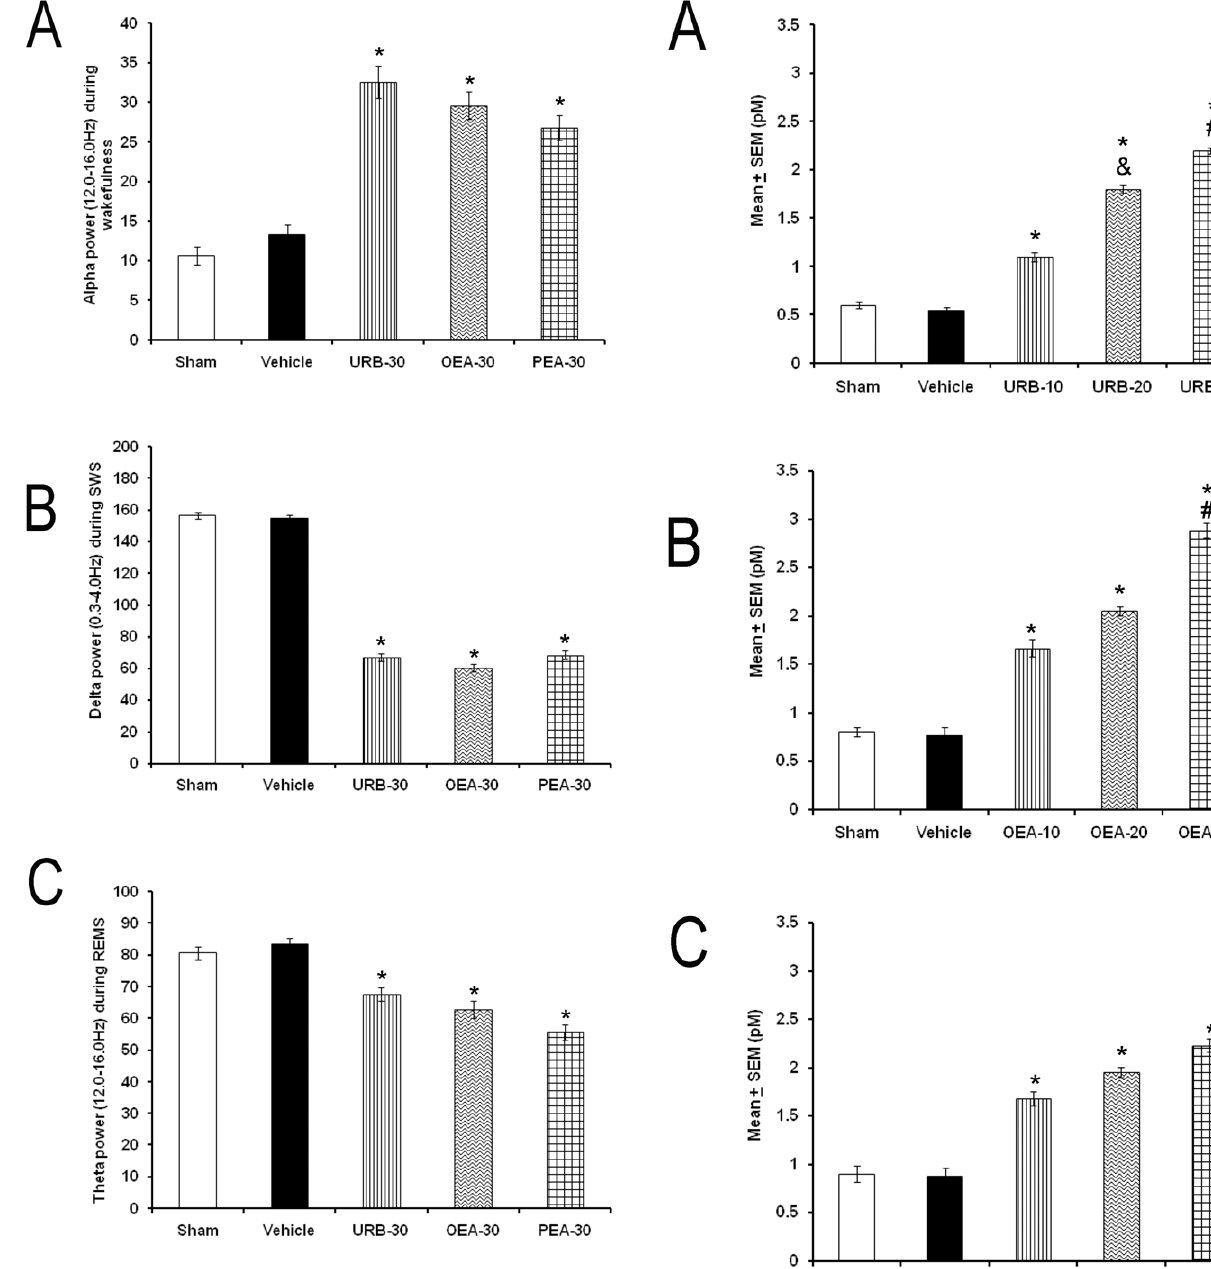
Figure 5. EEG alpha (for W; a =8–12 Hz. Panel A), delta (for SWS; d =0.5–4.0 Hz. Panel B) and theta (for REMS; h =6.0– 12.0 Hz. Panel C) power spectra (units, m V 2 ) in rats after the following treatments into dorsal raphe nuclei: Sham, vehicle, URB597, OEA or PEA (30 m g/1 m L; each compound). Data were calculated over 3 consecutive hours at every time point (Mean 6 SEM; * vs. Sham/Vehicle, p , 0.05).